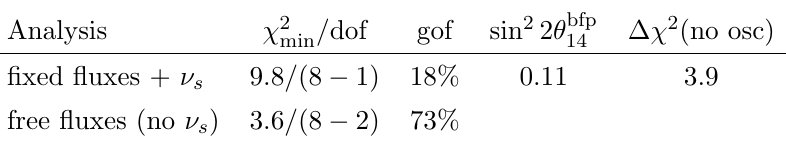
Table 1 . Fits to the Daya Bay (cid:13)ux measurements. The \(cid:12)xed (cid:13)uxes" analysis assumes the Huber & Mueller (cid:13)ux predictions [1, 2] (accounting for their quoted uncertainties) and includes (cid:22) (cid:23) e & 0 : 05 eV 2 , so that oscillations are in disappearance into sterile neutrinos (cid:23) s . We assume (cid:1) m 2 41 the averaging regime. For the \free (cid:13)uxes" analysis, (cid:13)uxes are allowed to vary freely, but (cid:18) 14 is set to zero. The goodness-of-(cid:12)t (gof) p -values are calculated by Monte Carlo simulation and agree roughly with the (cid:31) 2